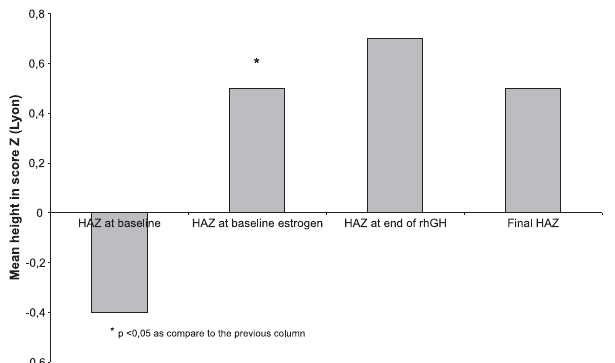
Figure 2 - Influence of estrogen replacement in the growth of the 11 girls with TS during rhGH